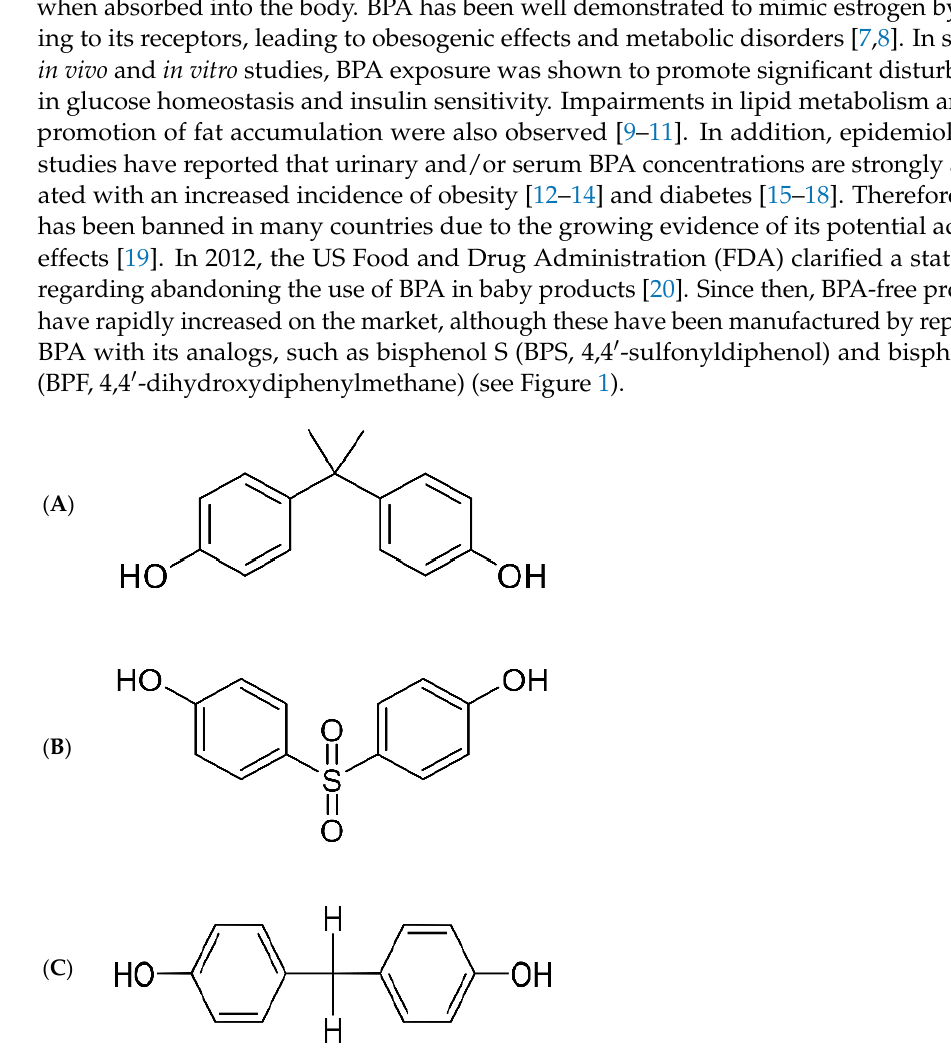
Table 1. Summary of studies reporting the association between BPS and BPF exposure and the in- cidence of obesity and diabetes in human populations.